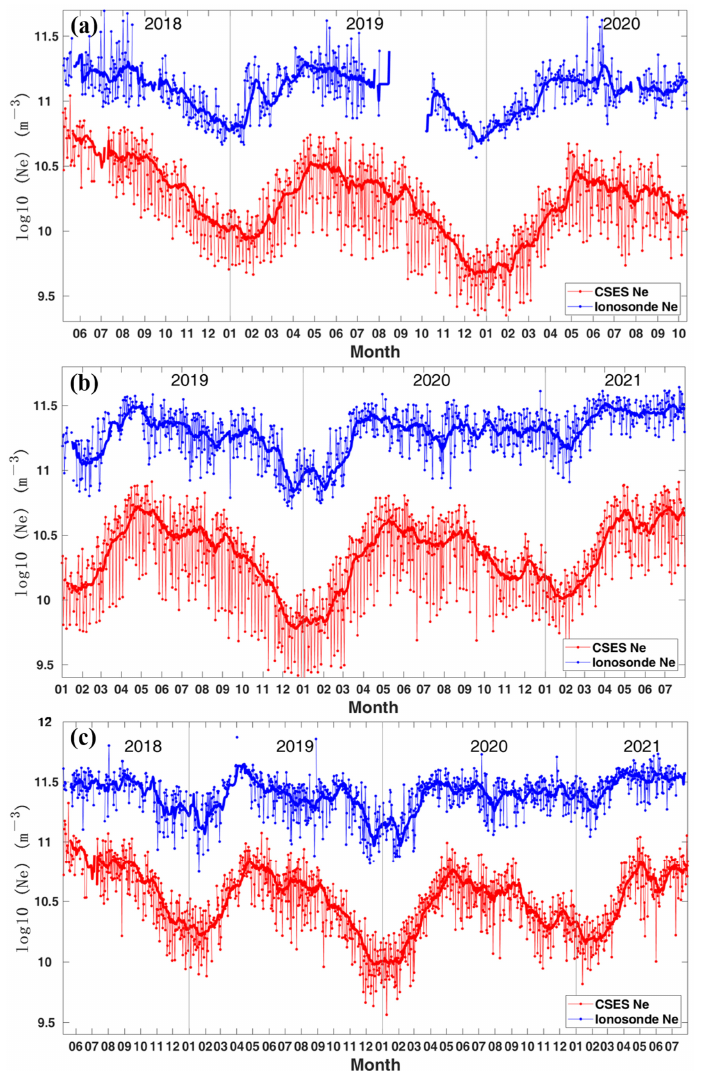
Figure 5. Time series of Ne for CSES and ionosonde. Panels ( a – c ) are for Leshan, Tengchong and Puer stations, respectively. In each panel, the red dotted line represents CSES Ne, and the blue dotted line denotes Ne at the satellite altitude inferred by ionosonde observations and IRI model. Red and blue lines are the 15-day running